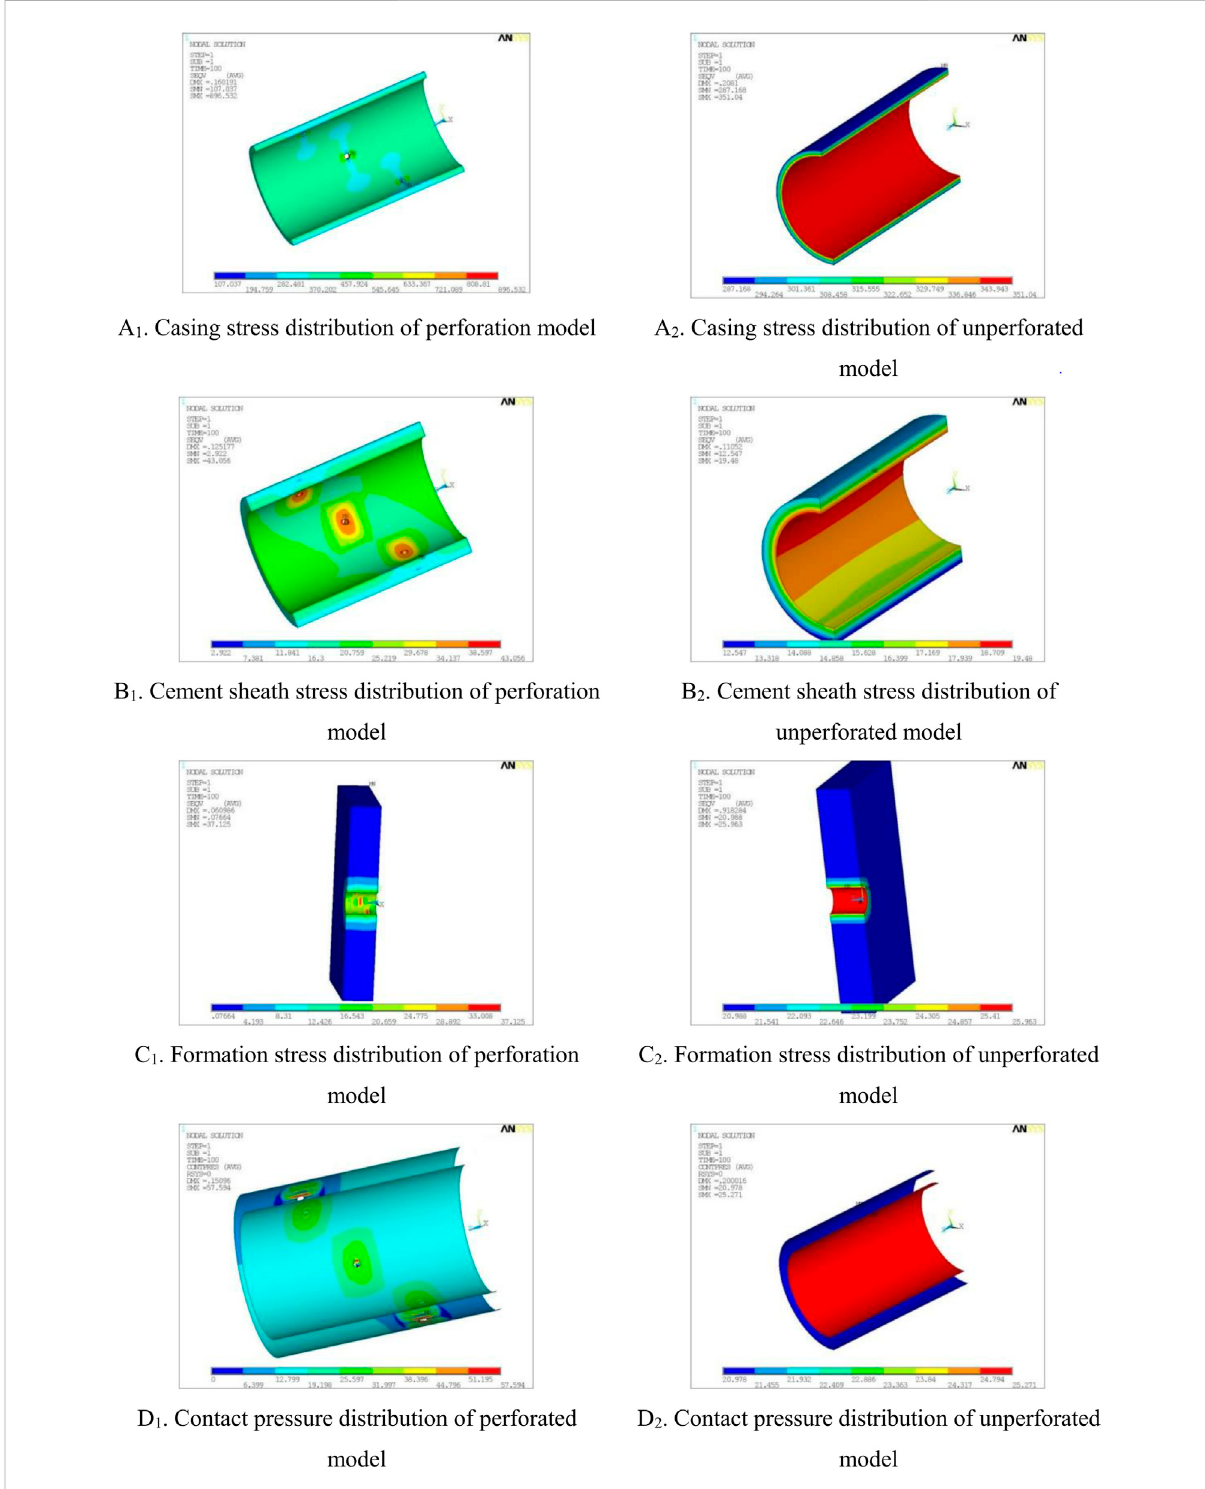
FIGURE 7 Comparison of stress distribution between perforated model and unperforated model under fracturing conditions. (A1) Casing stress distribution of prforation model. (A2) Casing stress distribution of unprforation model. (B1) Cement sheath distribution of prforation model. (B2) Cement sheath distribution of unprforation model. (C1) Formation stress distribution of prforation model. (C2) Formation stress distribution of unprforation model. (D1) Contact pressure distribution of prforation model. (D2) Contact pressure distribution of prforation model.